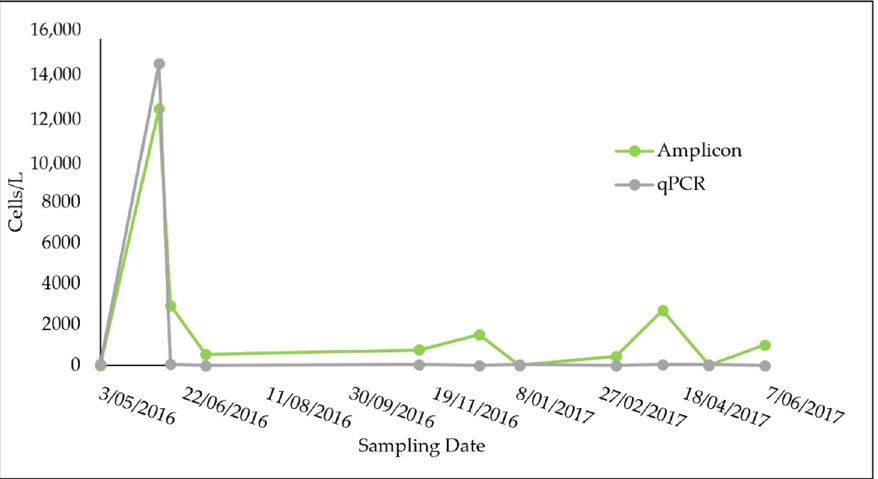
Figure 4. Bare Island P. minimum cell counts L − 1 with amplicon sequencing and qPCR across the BPA sampling period. Standard error bars are included for qPCR (too small to detect). Table 6. Linear regression between qPCR, metabarcoding, and light microscopy. qPCR vs. Amplicon Sequencing qPCR vs. Count